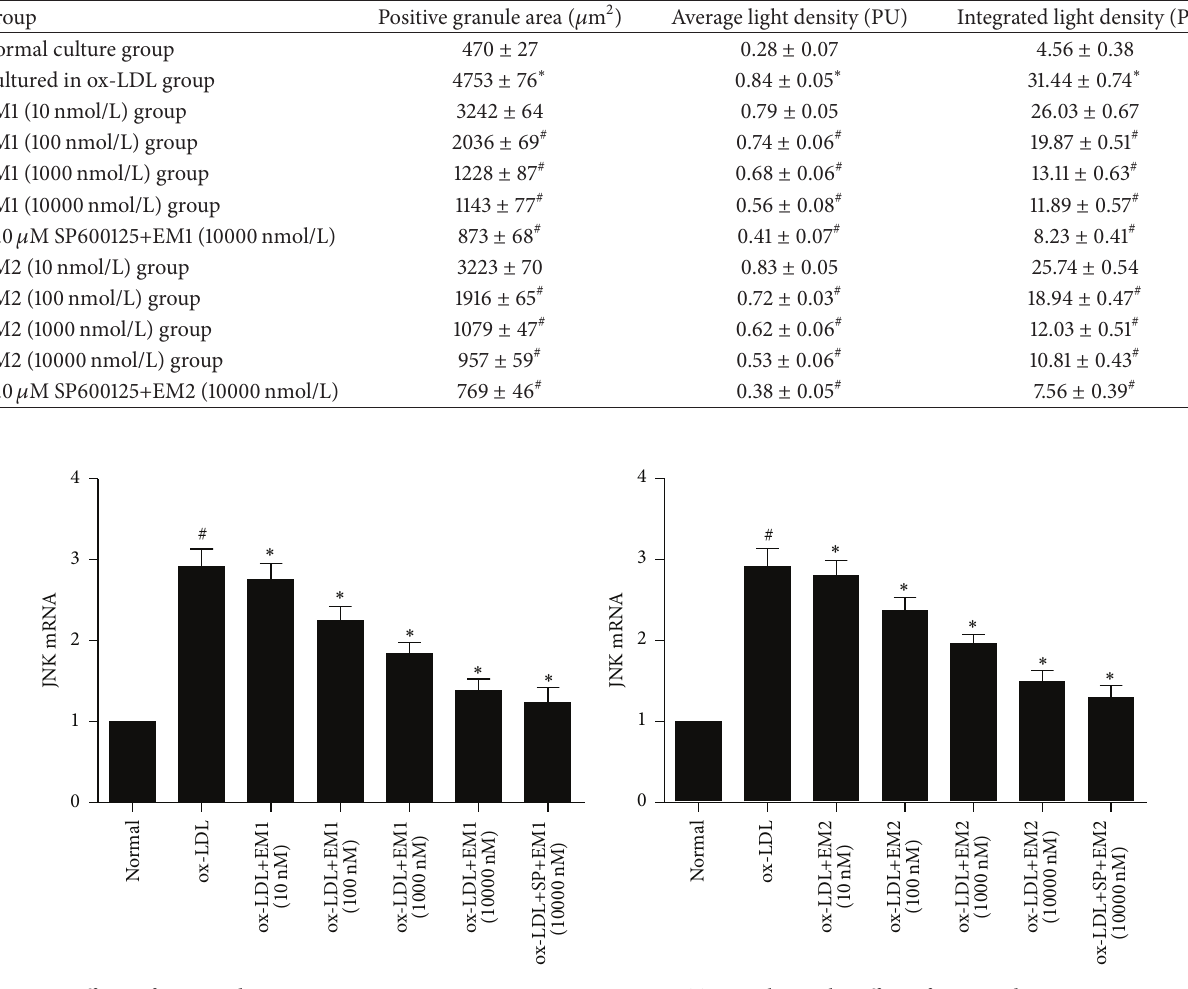
Figure 7: Effects of EM1 and EM2 on JNK mRNA expression in HUVECs. RT-PCR shows the effect of EM1 and EM2 on JNK mRNA expression in HUVECs induced by ox-LDL for 48 h. Data is expressed as mean ± SD. ∗ 𝑃 < 0.05 versus control. # 𝑃 < 0.05 versus ox-LDL.